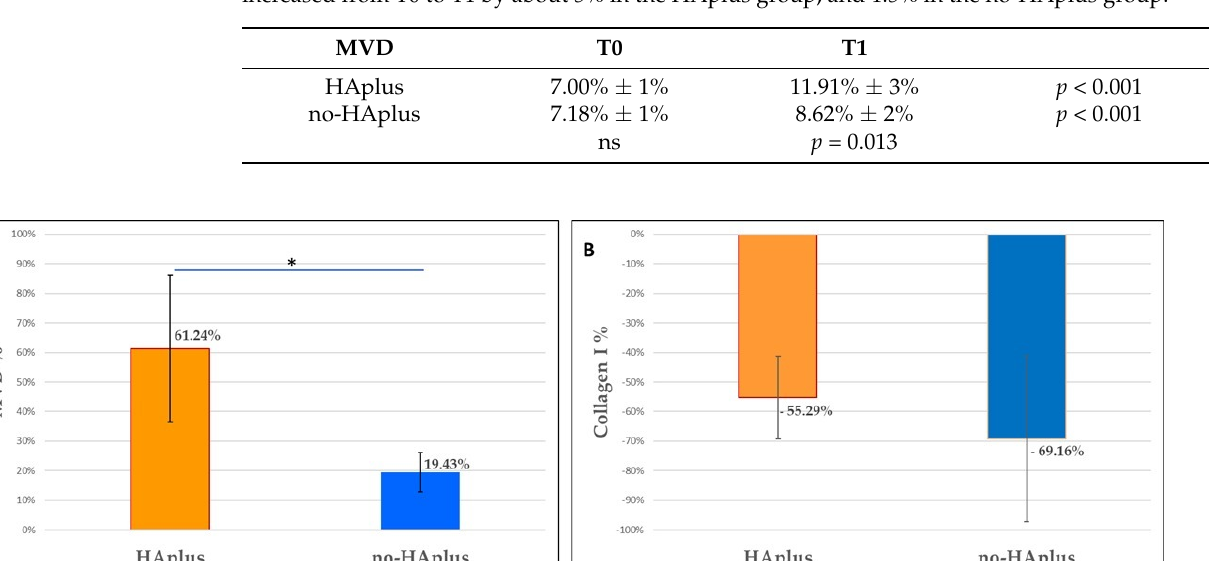
Figure 3. Histomorphometrical analysis. ( A ) Graphics show the increase in microvascular density (MVD) and ( B ) decrease in collagen content (Collagen I %) that occurred in both groups (HAplus, no-HAplus) after 10 days of healing. The MVD increases in HAplus sites resulted significantly higher than in no-HAplus sites (Wilcoxon signed-rank test) ( p < 0.001). Data were normalized on relative T0 values for both MVD and % Collagen.